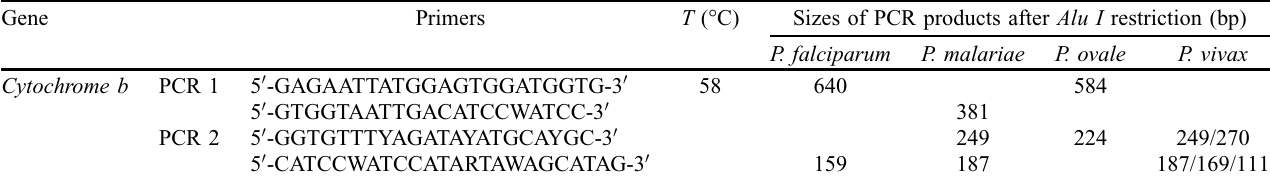
Table 1. Sequences of primer sets and restriction fragments for each species. Gene Primers T ( (cid:3) C) Sizes of PCR products after Alu I restriction (bp)